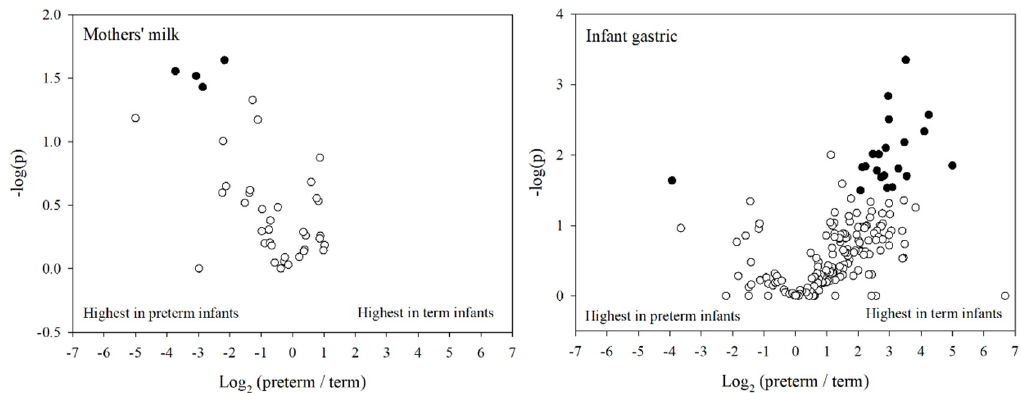
Figure 8. Volcano plots depicting fold change in bioactive peptide intensity ( x- axis, logarithmic) and p -value ( y -axis, logarithmic) between term and preterm infant milk and gastric samples. Filled circles indicate the peptide was significantly different between preterm and term infants ( p < 0.05), whereas the hollow circles are non-significant.